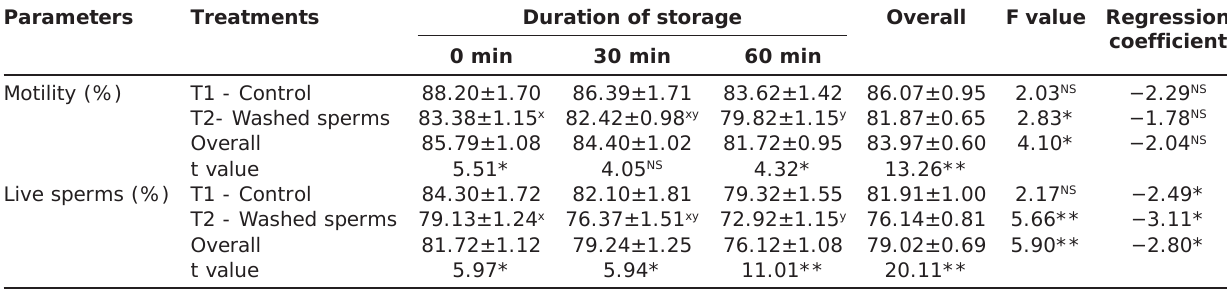
Table-3: The influence of washing of spermatozoa and duration of storage on motility and live sperms of RIR roosters.